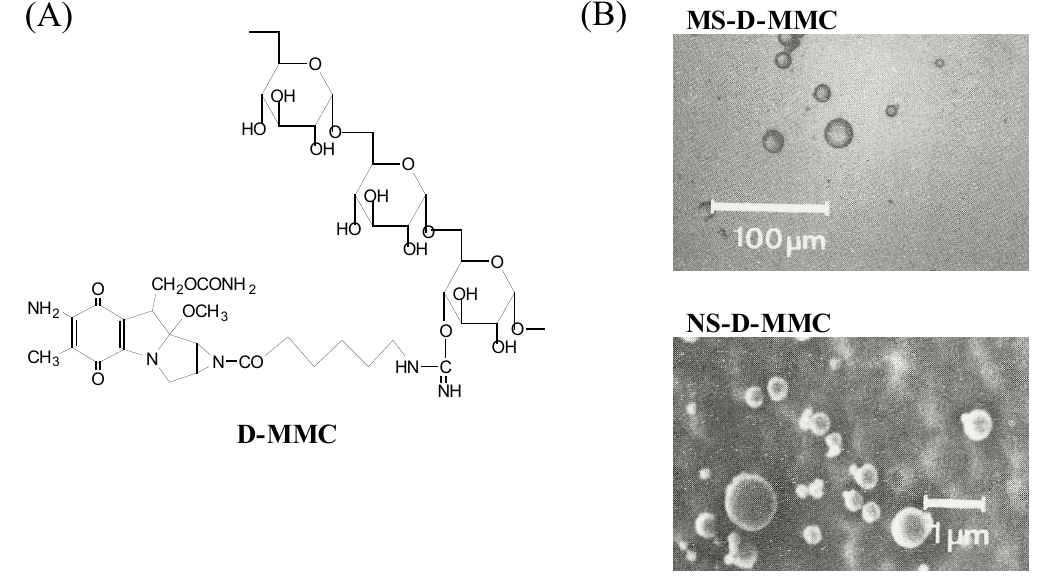
Figure 1. Chemical structure of dextran-MMC conjugate (D-MMC) (A) and scanning electron micrographs of gelatin micro- (MS-D-MMC) and nanospheres (NS-D-MMC)